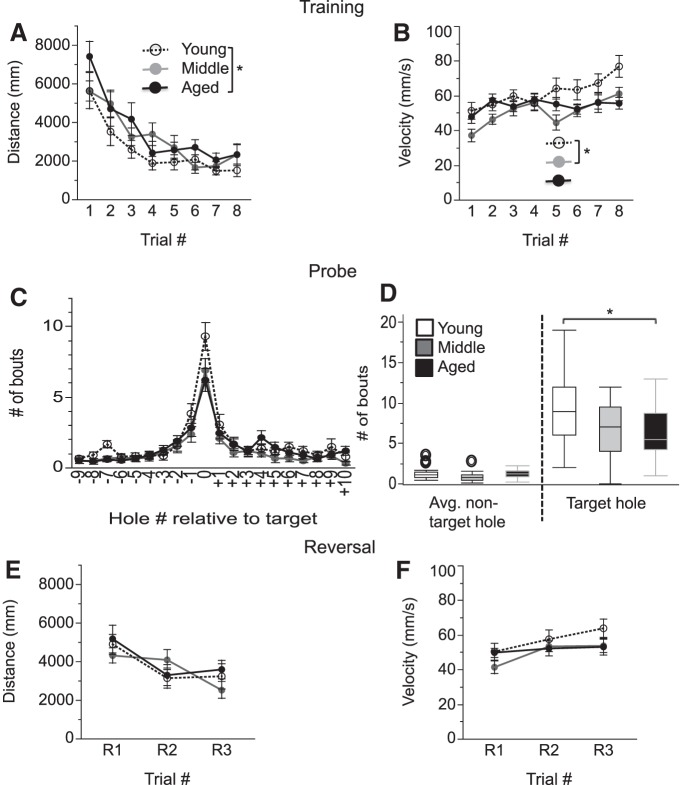
Barnes maze performance is impaired in aged mice. A, B, Training sessions. The distance travelled (A) and velocity of movement (B) until the mice entered the escape tunnel during training are shown. C, D, Probe trials. C shows the number of exploration bouts that were recorded at the location of the target hole (defined as position 0) as well as each individual nontarget hole. The absolute value of the “hole number relative to the target” reflects the distance from the target hole. D, The average number of exploration bouts at the nontarget and target holes are shown. E, F, Reversal phase; the distance travelled (E) and the velocity of the movement (F) during the reversal phase of the task are shown. Values are expressed as the mean ± SEM (A–C, E, F) or box plots, as defined in the Data analysis section in Materials and Methods (D). *p < 0.05.